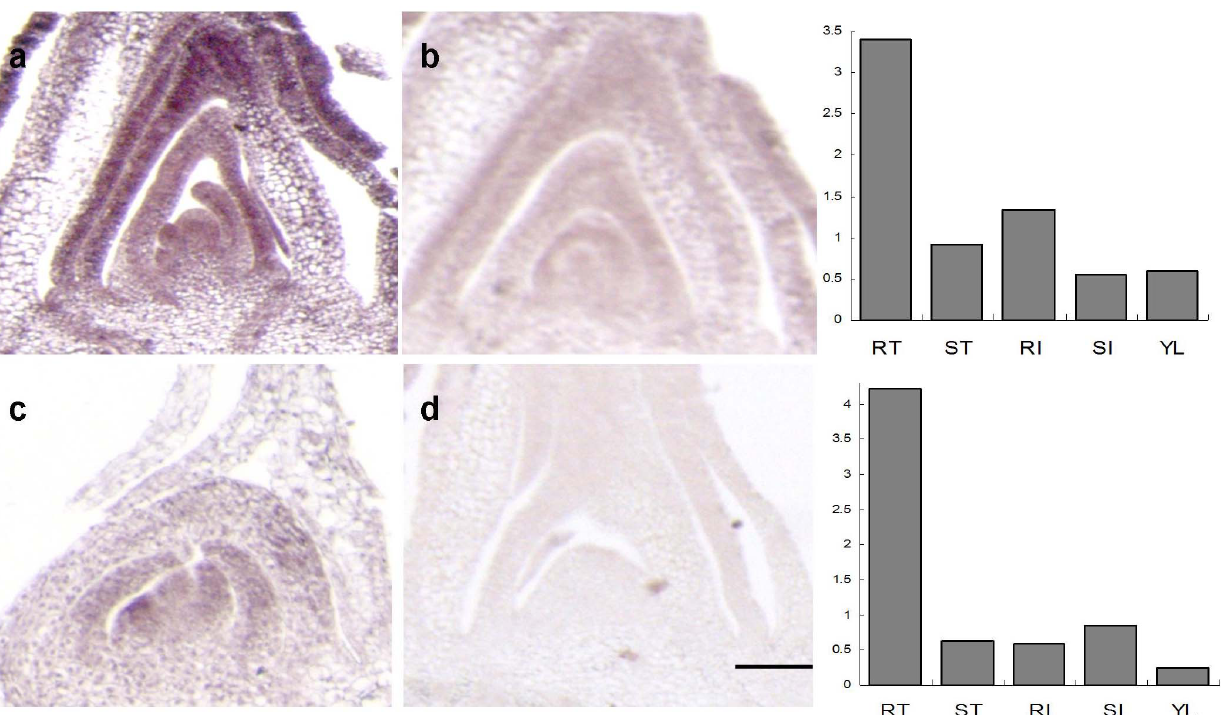
Figure 3. Validation of microarray data by insitu hybridization. In situ localization of transcripts corresponding to the genes (a) Sb01g047010 and (c) Sb06g028820 in S. propinquum rhizome tips are illustrated; (b) and (d) represent the sense probe for control. Corresponding microarray-based expression profiles of these two genes are also shown as bar graphs for comparison.